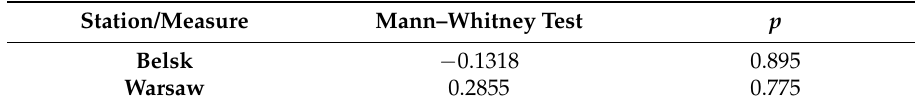
Table 5. Results of the Mann–Whitney test together with the right values of probability for Belsk and Warsaw stations for 2015.